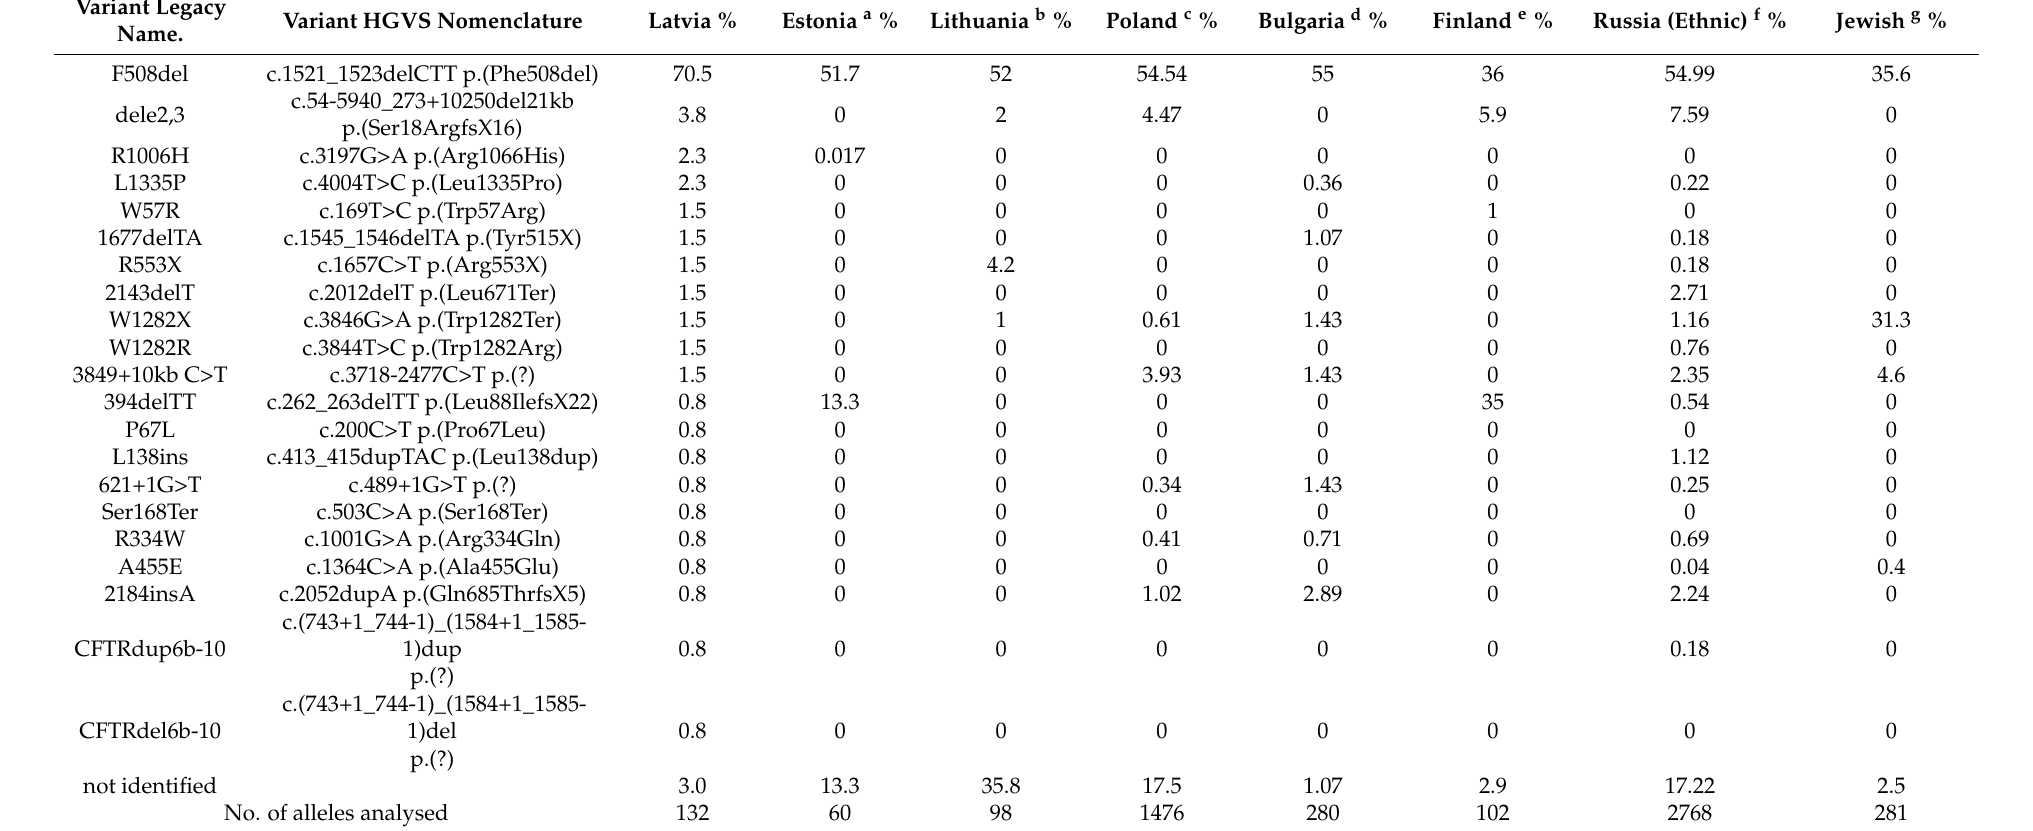
Table 2. Frequencies of CFTR variants detected in CF patients from Latvia and neighbouring